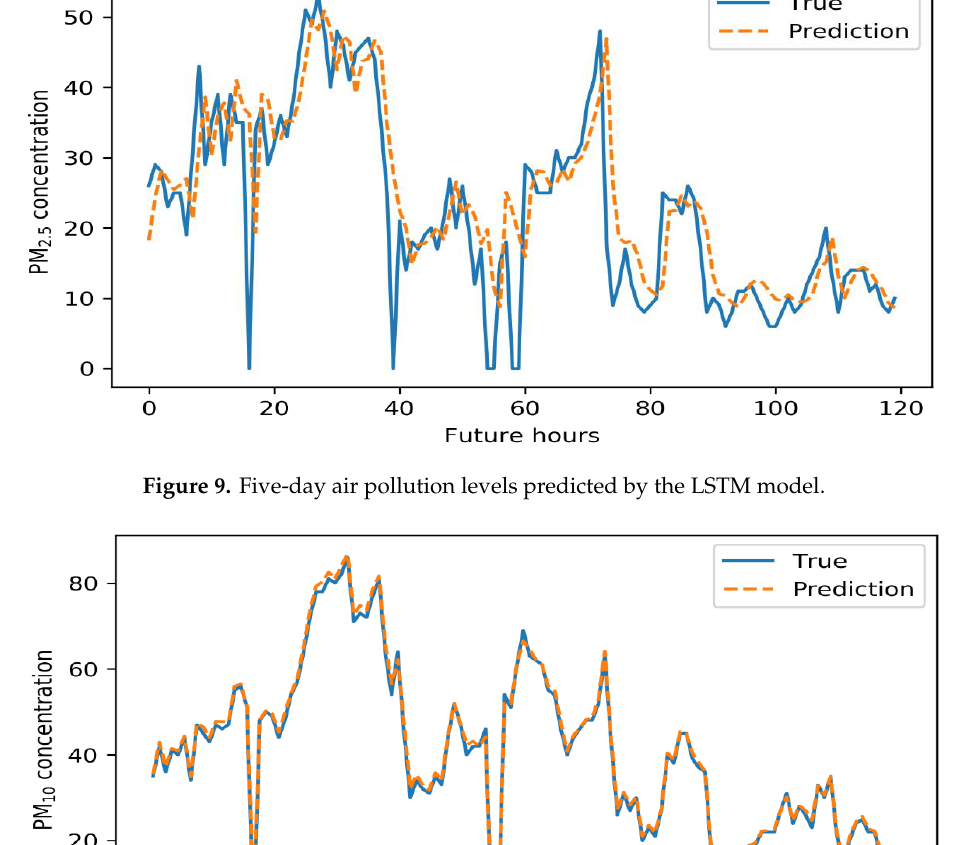
Figure 11. Five-day air pollution levels predicted by the CNN–LSTM model.